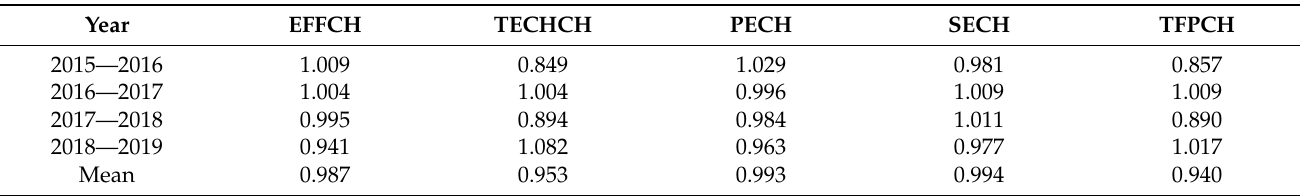
Table 5. Malmquist index of medical and health services in Jiangsu Province and its decomposition during 2015–2019 (time dimension).